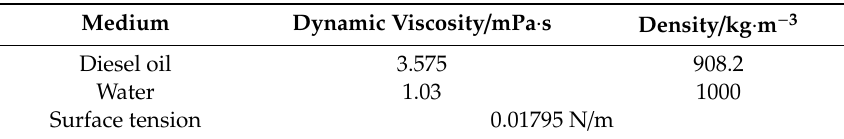
Figure 4. Initial water content. Table 2. Physical parameters.